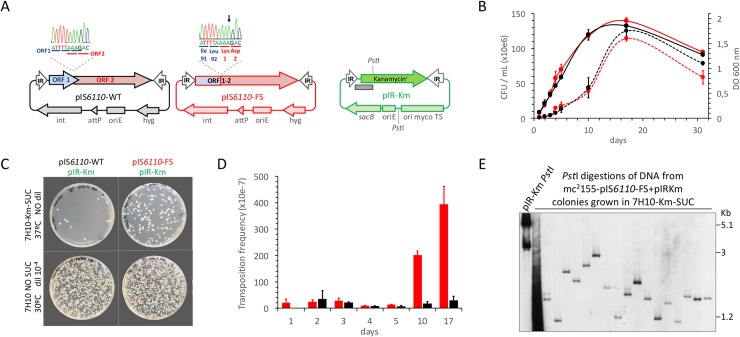
Construction of a transcriptionally active IS6110 and measure of transposition frequencies during laboratory growth.(a) Plasmids used in the transposition reporter system. pIS6110-WT and pIS6110-FS are mycobacterial integrative plasmids carrying either the wild type IS6110 or a mutated variant producing a transcriptionally active transposase respectively. The upper side of this panel shows Sanger sequencing histograms indicating the position of the A insertion in pIS6110-FS. pIR-Km is a conditionally replicating plasmid with thermosensitive origin of replication and the sacB gene conferring sucrose sensitivity. This plasmid contains a Kanamycin resistance cassette (km) flanked by the IR regions of IS6110. Positions of PstI sites and probe (grey rectangle) used in RFLP shown in panel (e) are indicated. (b) Growth rates of liquid cultures at 30°C of M. smegmatis transformed with either pIS6110-WT+pIR-Km (black lines) or pIS6110-FS+pIR-Km (red lines). Growth curves measured by OD600 and enumeration of CFU/mL are represented by continuous or dotted lines respectively. Error bars represent the standard deviation from three independent cultures. (c) CFU from M. smegmatis cotransformed with pIS6110-WT+pIR-Km or pIS6110-FS+pIR-Km and plated on 7H10 media supplemented with or without kanamycin and sucrose. Dilution used and incubation temperature are indicated. Note the increase in the number of CFU grown in kanamycin and sucrose medium for the pIS6110-FS variant relative to the pIS6110-WT. (d) Determination of transposition frequencies in M. smegmatis cotransformed with pIS6110-WT+pIR-Km (black columns) or pIS6110-FS+pIR-Km (red columns). Error bars indicate the standard deviation from three independent experiments. Note that the transcriptionally active transposase in pIS6110-FS increases up to 20-fold its transposition frequency relative to the wild type transposase in exponential and stationary periods. (e) RFLP analysis of DNA from colonies grown in kanamycin and sucrose plates resulting from transposition events. Note the loss of signal for pIR-Km indicative of the appropriate plasmid loss and the concomitant presence of an aleatory band pattern indicative of randomised transposition in the M. smegmatis chromosome.